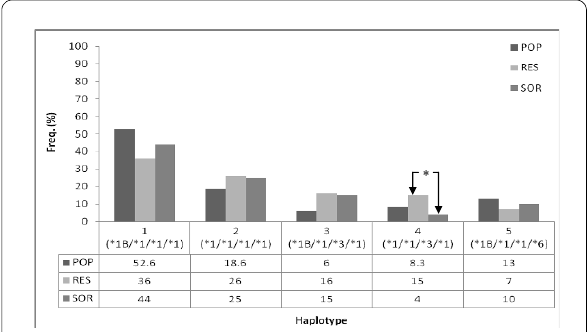
Figure 1 Haplotype comparison of MDR1 allele frequency in RES, SOR and POP . Comparison of POP and RES data did not show any signif- icant differences for haplotypes C-G-C and C-G-T. RES verses SOR; haplo- type(CGT) POP = Random Ghanaian population, RES = responders, SOR = Suboptimal responders.